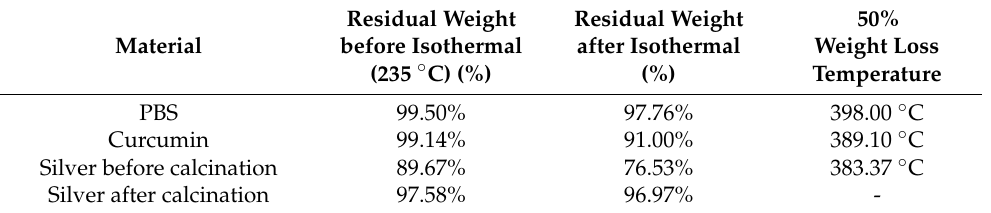
Table 3. Initial degradation temperatures and weight shares at 235 ◦ C for PBS, curcumin and